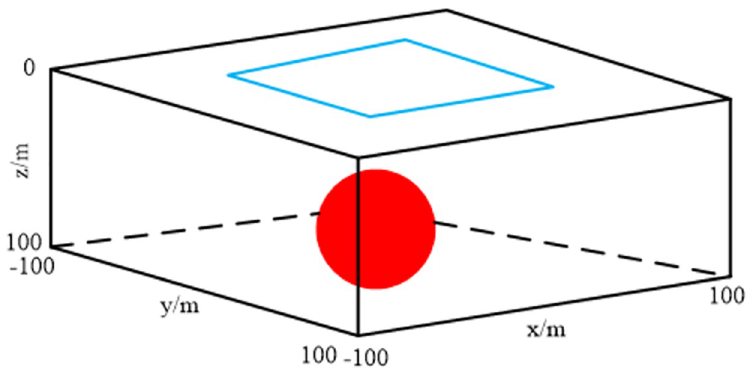
Fig 12. Deep single water-body model. The red sphere is the water-bearing object, while the blue rectangle is the transmission